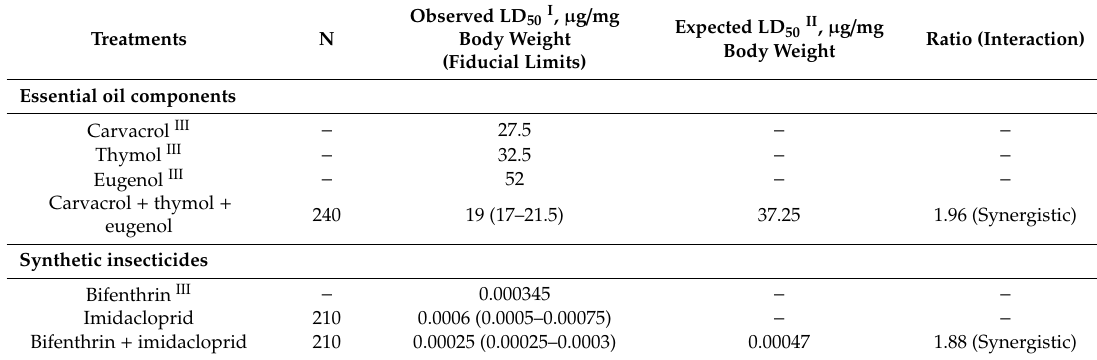
Table 1. Topical toxicity of monoterpenoids, synthetic insecticides and their respective binary and tertiary mixtures against adult male bed bugs of the Harlan susceptible